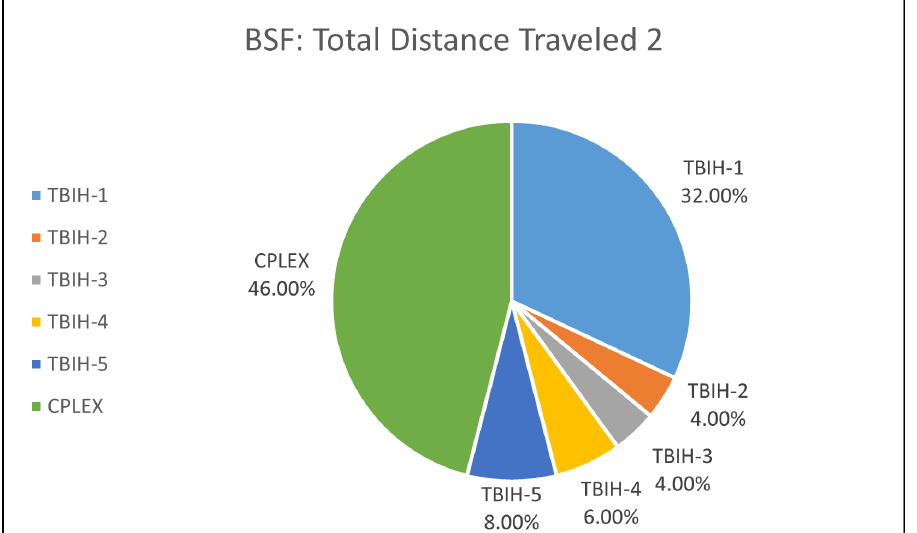
Figure A24. Algorithms performance compared to matheuristic rollout applied in PDS-RA: total BSF measured for total travelled distance over all test instances applied (including 10 non-benchmarked measurements).